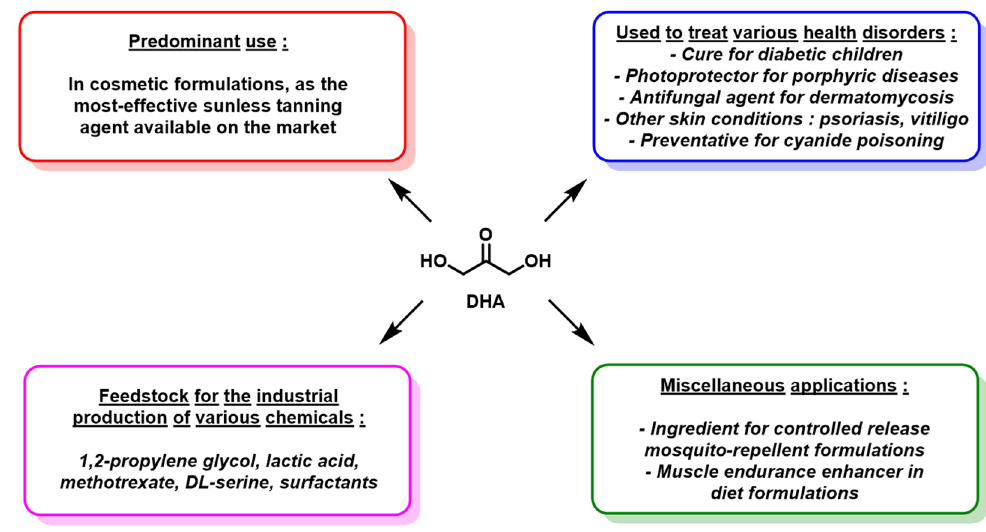
Figure 4. Synoptic representation of the reported applications of raw DHA.